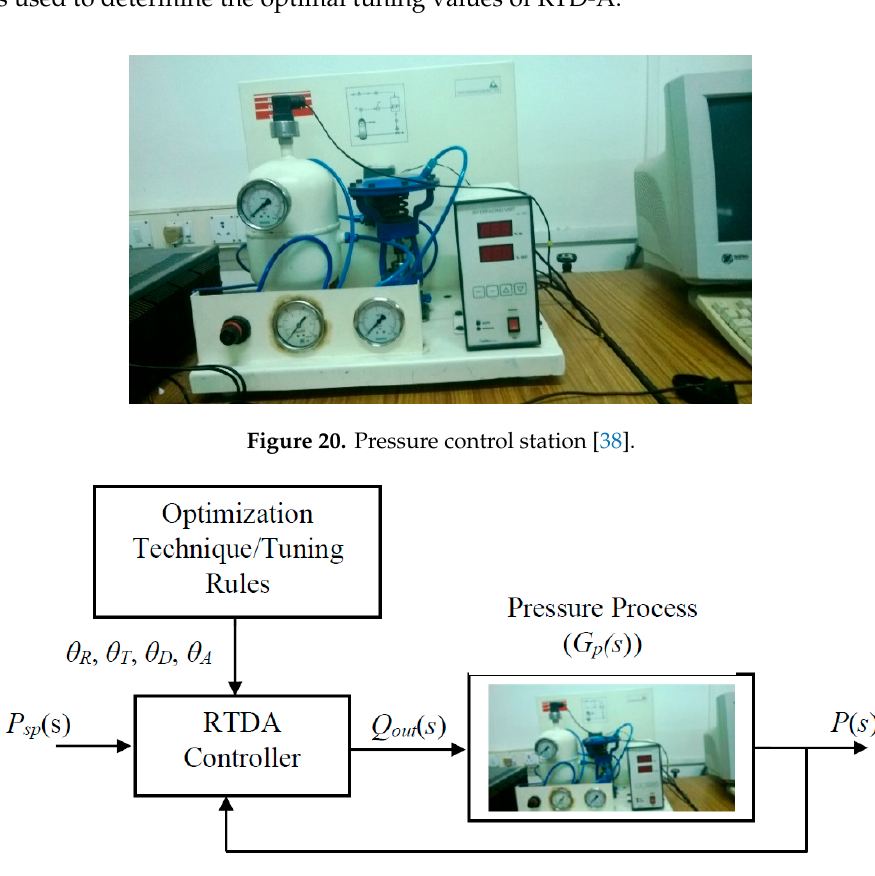
Figure 21. Pressure control station with the RTD-A controller. Table 11. Example 2: Tuning parameters with tuning methods.